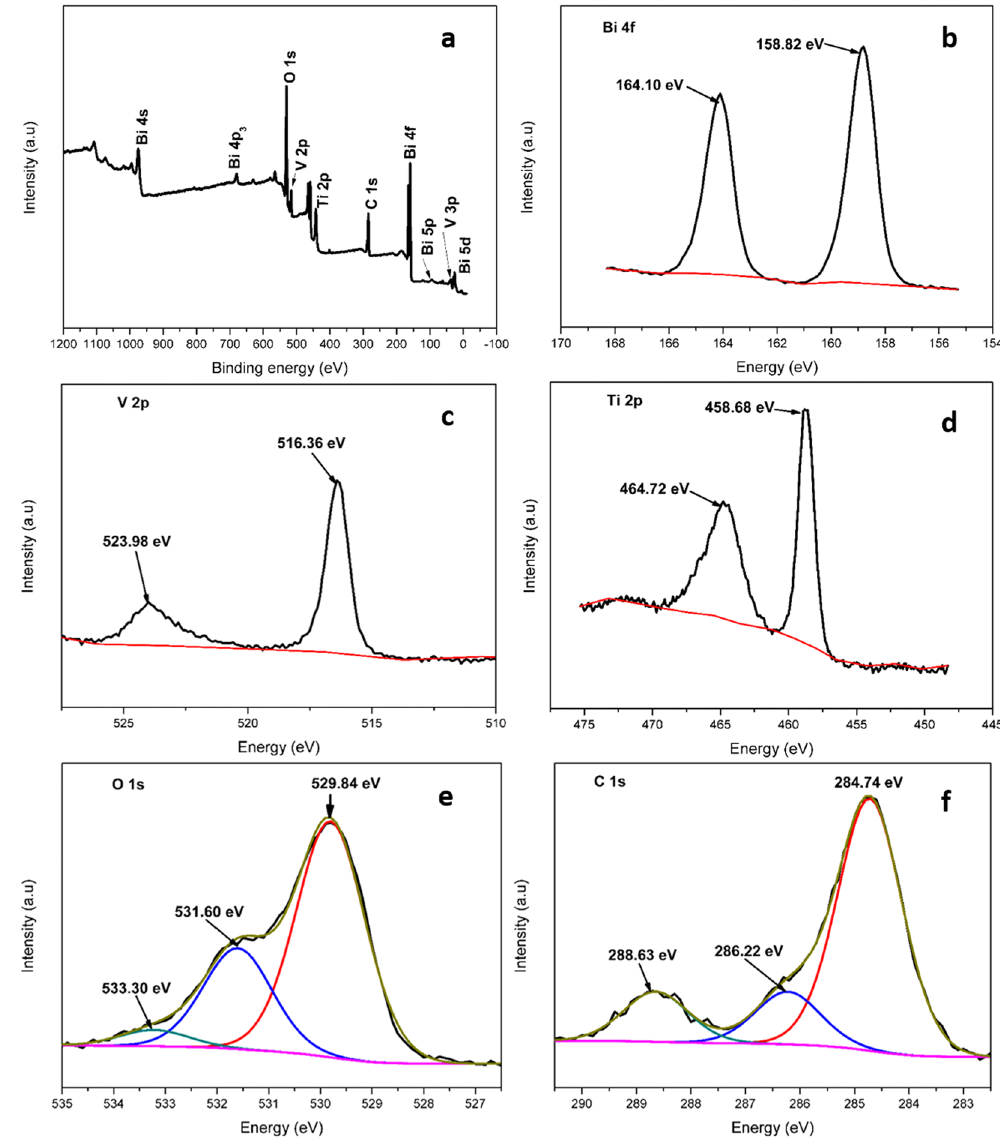
Figure 8. The XPS spectra of 3-2 Bi:Ti; ( a ) full survey spectrum, ( b ) Bi 4 f spectrum, ( c ) V 2p spectrum, ( d ) Ti 2p spectrum, ( e ) O 1 s spectra and ( f ) C 1 s